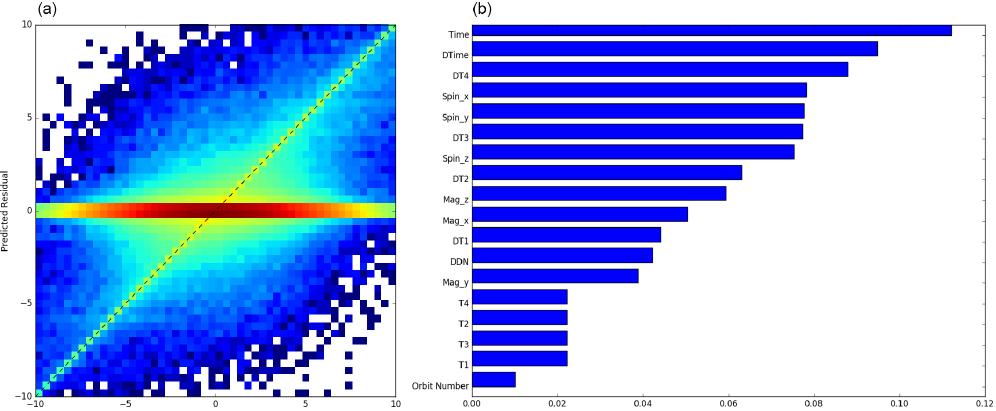
Figure C1. (a) Heatmap of the predicted C sp residuals (vertical axis) against the observed ones (horizontal axis), colored in log-scale. (b) Rank of importance of different parameters. Spin(Mag)_x, _y and _z correspond to the spin rate (magnetic field) on the x , y and z axes, respectively; DDN stands for the day of the year, and please refer to text in Appendix C for the meaning of other variables.